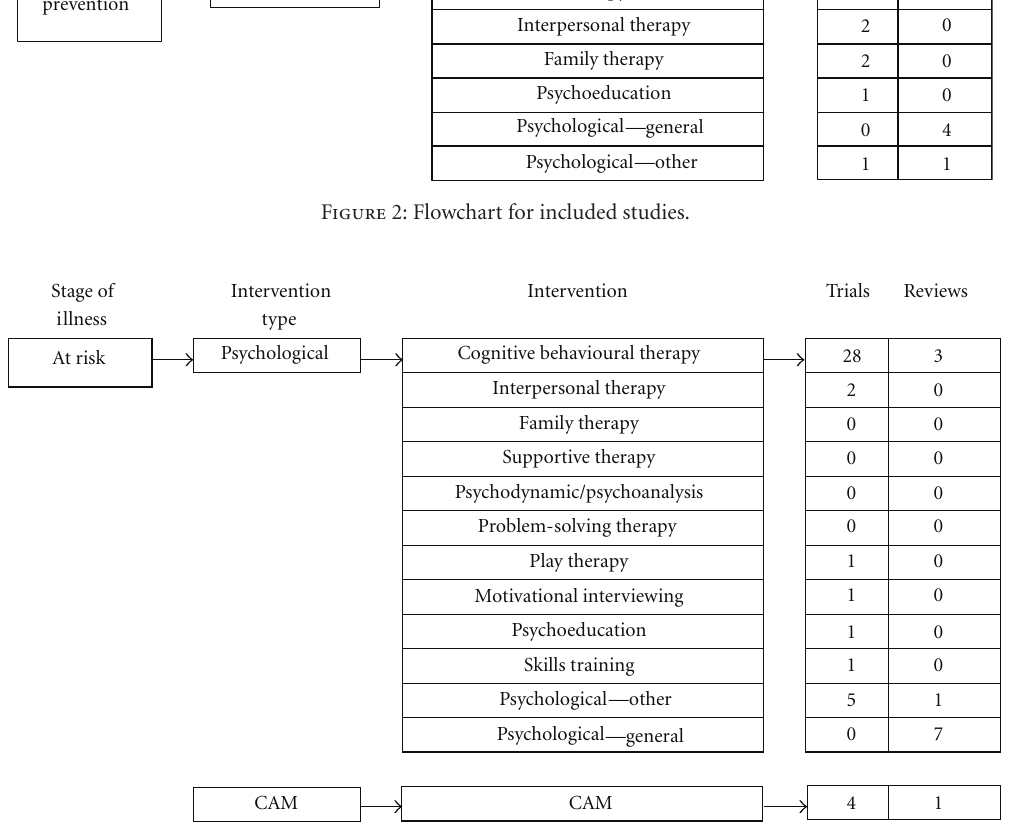
Figure 3: Distribution of included indicated and selective preventive